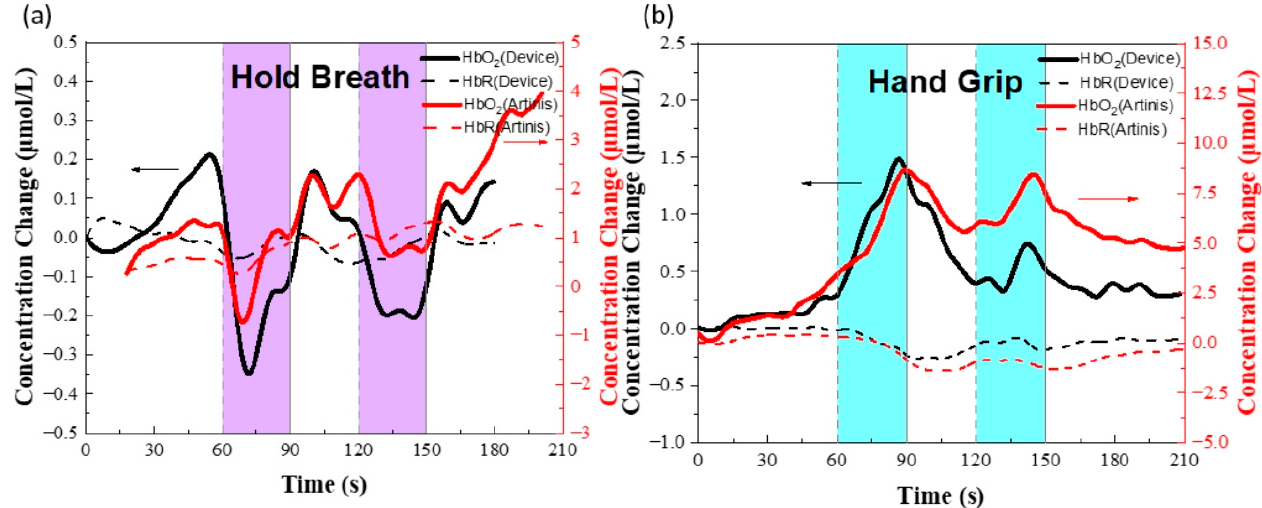
Figure 5. Data collection of systemic and cerebral hemodynamics from healthy young adults. ( a ) HbO 2 and HbR measurements from our device and a commercialized fNIRS instrument (named Artinis) during a physiological validation using a breath-holding test. Complete session data. The solid black lines represent device HbO 2 , the red lines are Artinis HbO 2 , and the shaded purple areas represent breath-holding periods. Characteristic dips and recovery in HbO 2 are visible in these data. ( b ) Our device and a commercialized fNIRS instrument validation using a hand-gripping test.